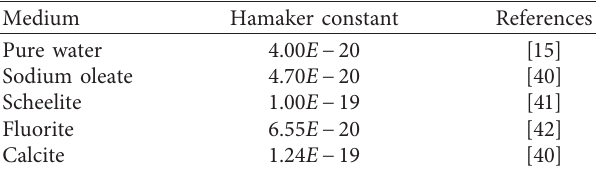
Table 1: Hamaker constant for two identical media in vacuum. Medium Hamaker